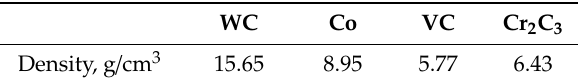
Table 4. Starting powders bulk